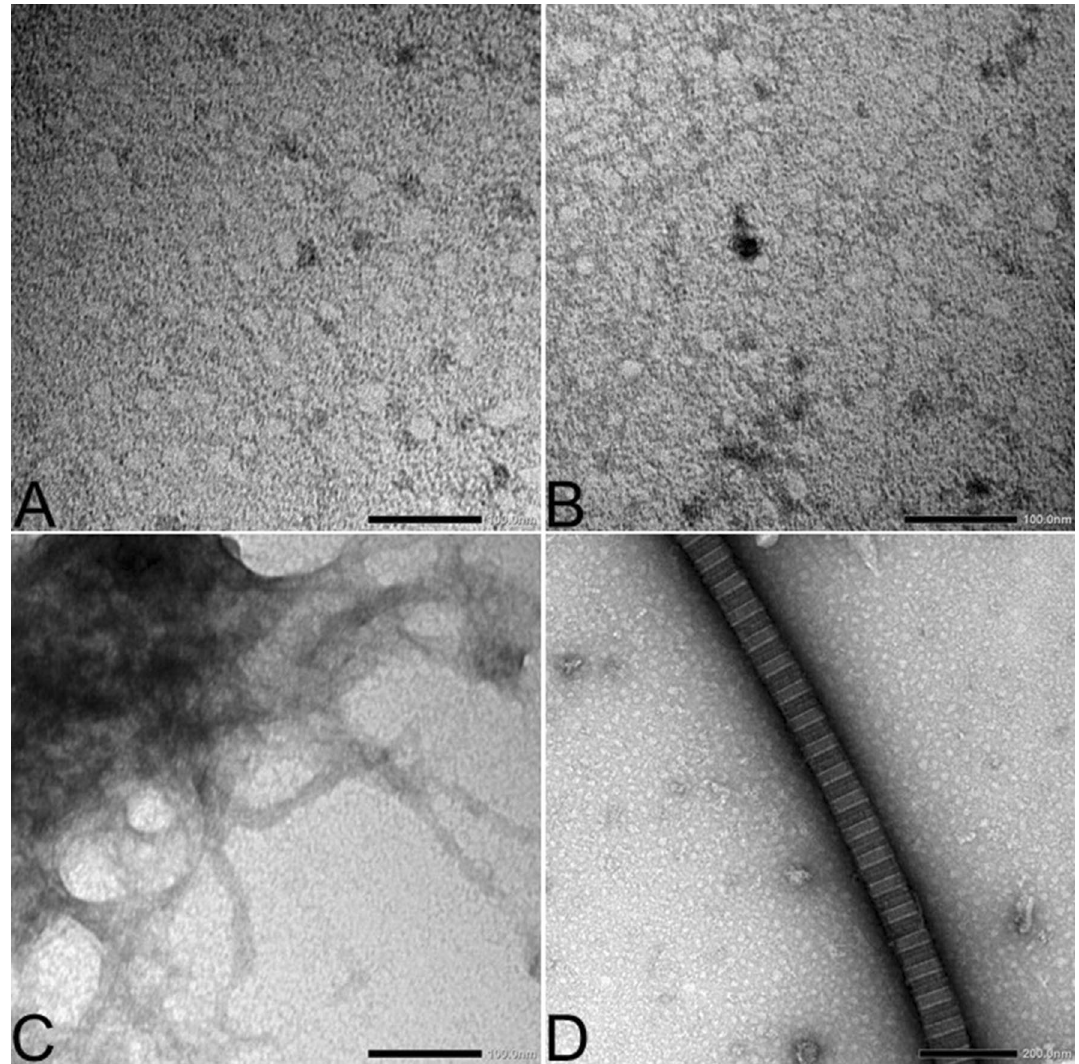
Figure 2. Alpha-synuclein (α-syn) extracted from the pars intermedia of PPID-affected horses exhibits a fibrillar ultrastructure as visualized by transmission electron microscopy (TEM). ( A ) TEM image of the background staining showing the absence of fibrils in equine α-syn isolated by immunoprecipitation (IP) from the pars intermedia of a young horse. (Scale bar, 100 nm.) ( B ) TEM image of α-syn isolated by IP from pars intermedia of an aged horse representing background staining (no fibrils). (Scale bar, 100 nm.) ( C ) TEM image of positively stained equine α-syn fibrils isolated by IP from the pars intermedia of a PPID-affected horse. (Scale bar, 100 nm.) ( D ) TEM image of a collagen fiber. (Scale bar, 200